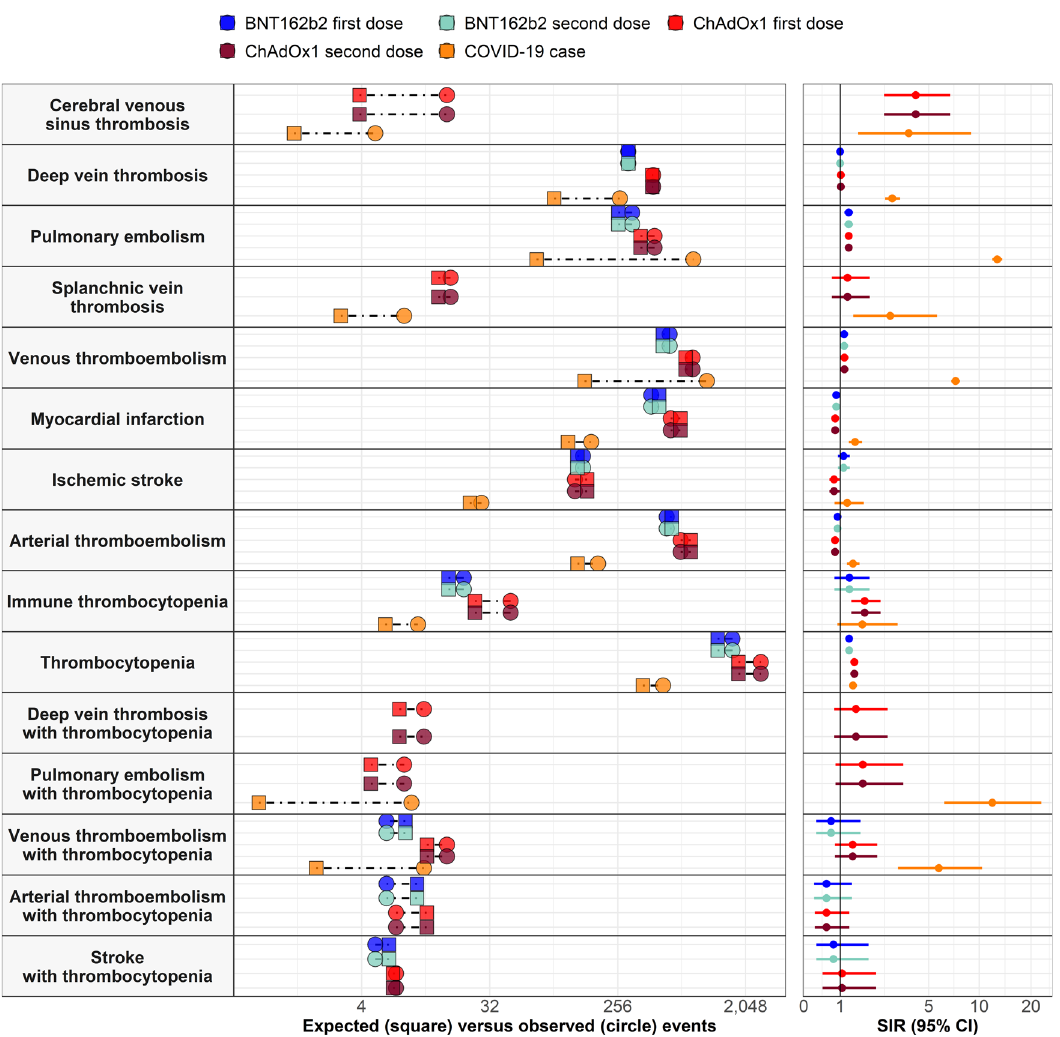
Fig. 2 | Background and post-vaccine rates of thromboembolic events and thrombocytopenia by age. Events with less than 5 occurrences have been omitted for privacy reasons. Point estimates with 95% con fi dence